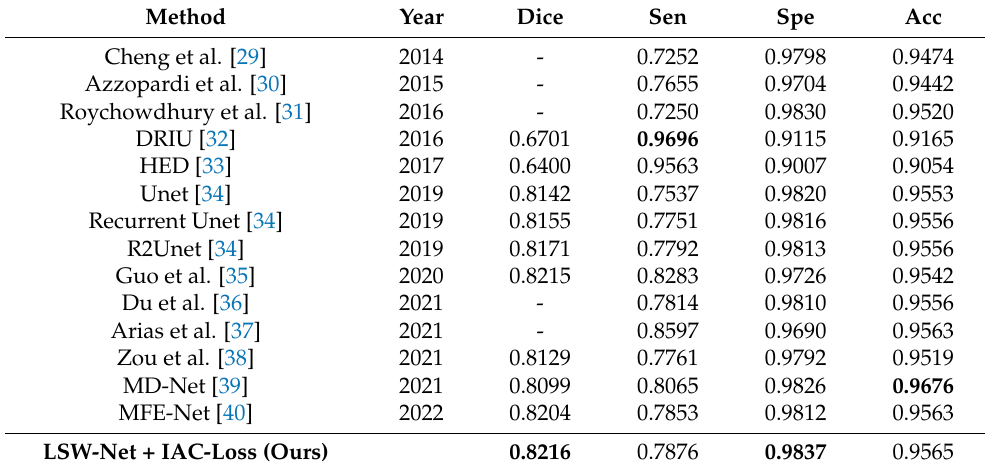
Table 4. Comparison of LSW-Net + IAC-Loss model with some advanced models on